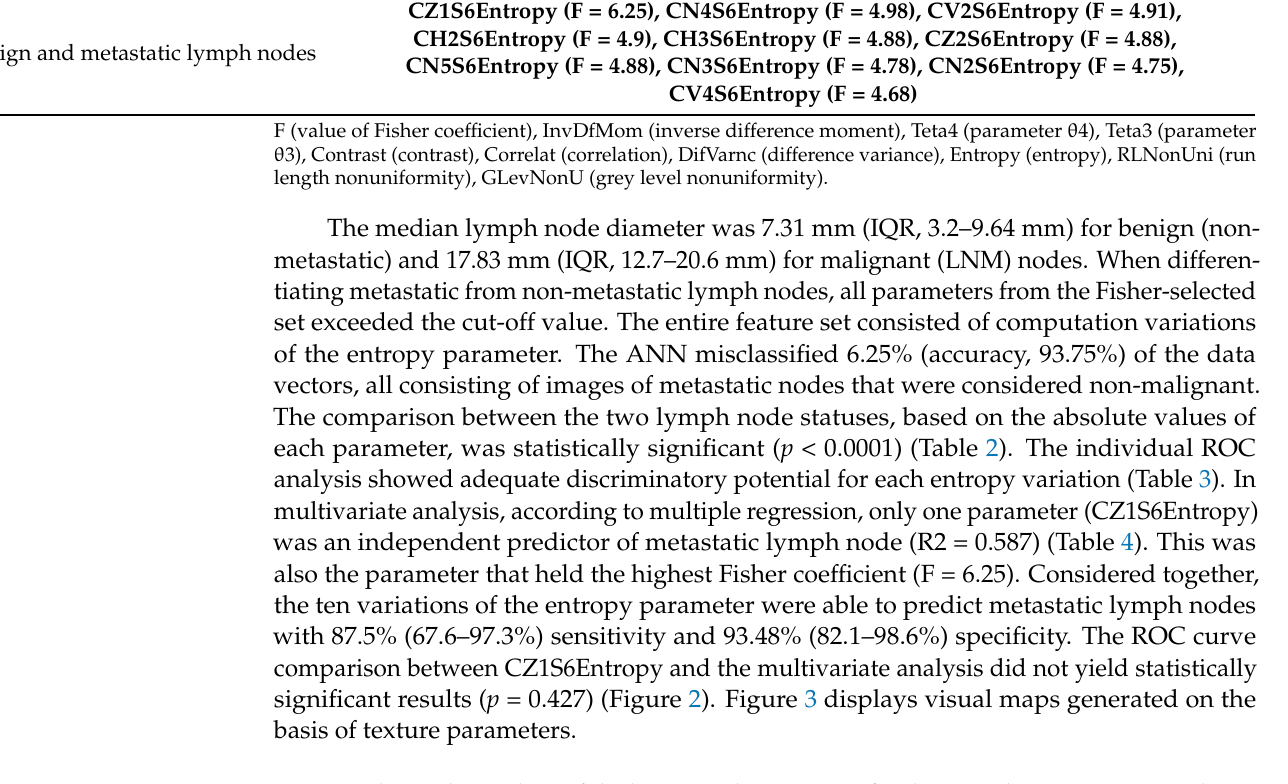
Table 2. The median values of the best-suited parameters for distinguishing metastatic and non- metastatic lymph nodes and the univariate analysis results. Between the brackets, values correspond- ing to the interquartile